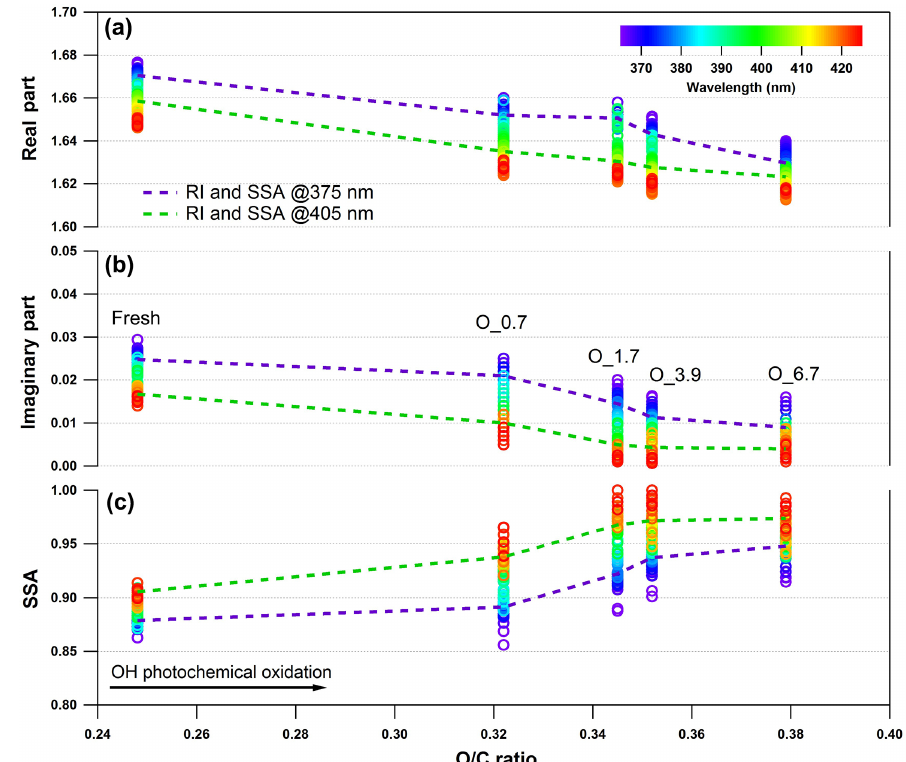
Figure 5. Evolution of the retrieved wavelength-dependent complex RI and SSA as a function of O:C ratio for tar ball particles upon OH photochemical oxidation: (a) real part, (b) imaginary part, and (c) SSA calculated for 150nm particles. The color scale shows the span in the RI for the wavelengths measured from 365 to 425nm. For clarity, error bars for O:C ratio ( ± 0 . 01), RI ( ± 0 . 007 for real part, and ± 0 . 003 for imaginary part on average), and SSA ( ± 0 . 006) are not shown. Two dashed lines trace the RI and SSA at 375nm (purple) and 405nm (green). O_0.7–O_6.7 represent equivalent atmospheric photochemical oxidation for 0.7 and up to 6.7